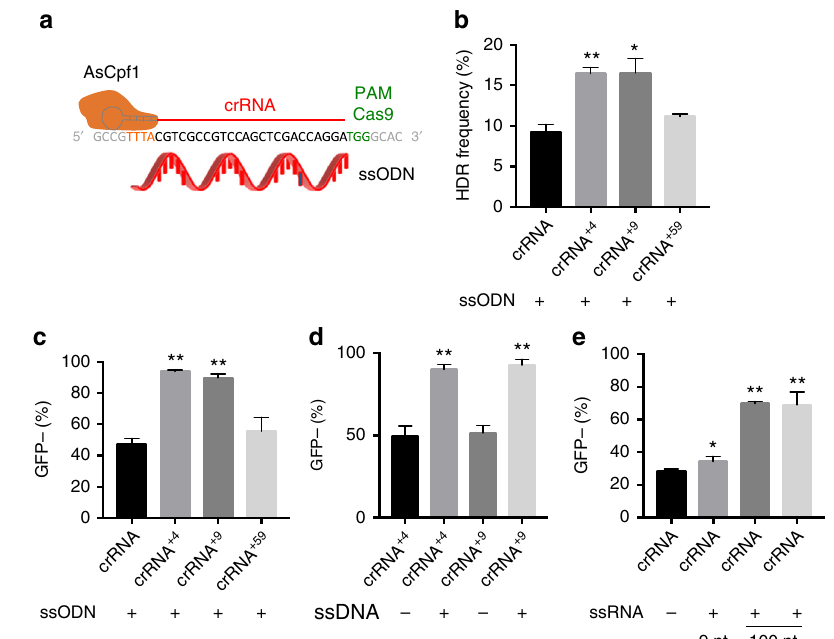
Fig. 3 Single-stranded DNA has synergistic effects with 5 ′ extended crRNAs and enhances both NHEJ and HDR in HEK cells. a Cpf1 RNP and ssODN were electroporated into cells and the HDR and NHEJ rates were determined. b The HDR frequency in GFP-HEK cells is enhanced with Cpf1 RNP + . The donor ssODN contained a restriction enzyme site, which was used for a restriction enzyme digestion assay to determine the HDR frequency. Mean± SE, n = 3. * p < 0.05, ** p < 0.01 by Student ’ s t test compared to crRNA control. c GFP knockout ef fi ciency of Cpf1 RNP + was further improved in GFP-HEK cells when ssODN was delivered together with electroporation. Cpf1 RNP + with various 5 ′ extended crRNAs and donor ssODN were delivered to GFP-HEK cells using electroporation. Mean ± SE, n = 3. ** p < 0.01 by Student ’ s t test compared to crRNA control. d The GFP knockout ef fi ciency of Cpf1 RNP + was improved in GFP-HEK cells when ssDNA was exogenously added. Cpf1 RNP + with various 5 ′ extended crRNAs and random 100 nt ssDNA without homology to the target sequence were delivered to GFP-HEK cells using electroporation. ssDNA enhanced gene editing ef fi ciency of Cpf1 RNP close to 90%. Mean ± SE, n = 3. ** p < 0.01 by Student ’ s t test compared to each without ssDNA control. e ssRNA enhances the knockout ef fi ciency of Cpf1 RNP in GFP-HEK cells. Cpf1 RNP and random ssRNAs (without sequence similarity) were delivered to GFP-HEK cells using electroporation. Mean± SE, n = 3. * p < 0.05, ** p < 0.01